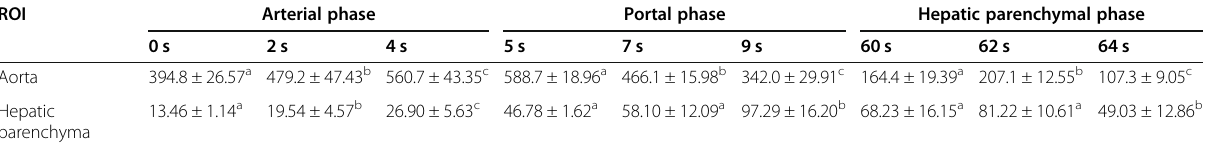
Table 1 Mean enhancements (HU) of the aorta and hepatic parenchyma in the arterial, portal and hepatic parenchymal phases ROI Arterial